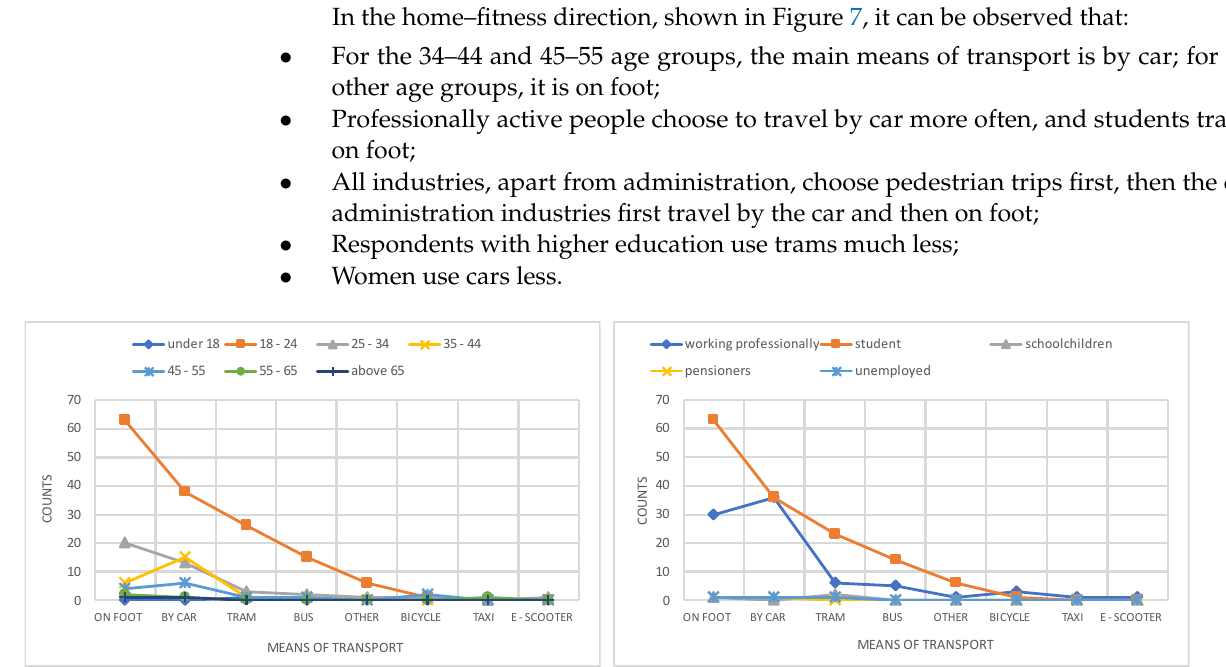
Figure 7. The choice of individual means of transport in the home – fitness direction.